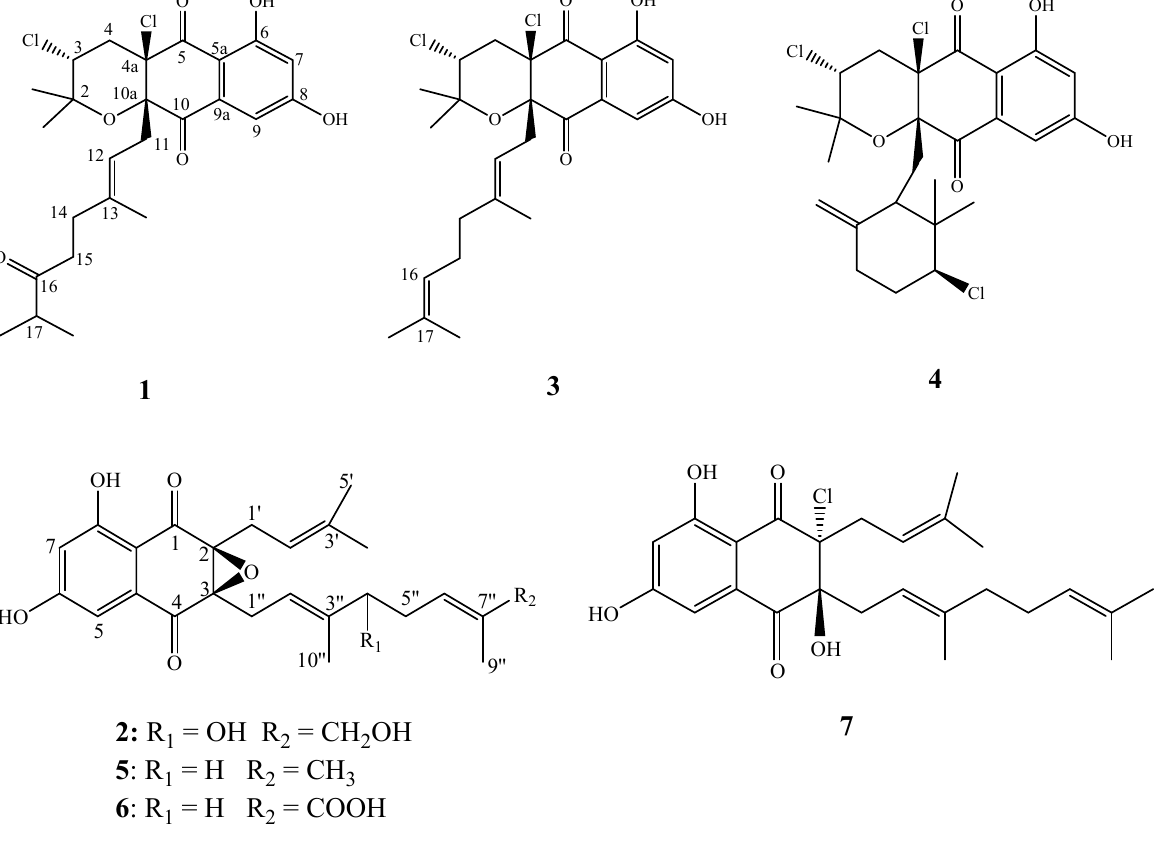
Figure 1. Chemical structures of compounds 1 – 7.